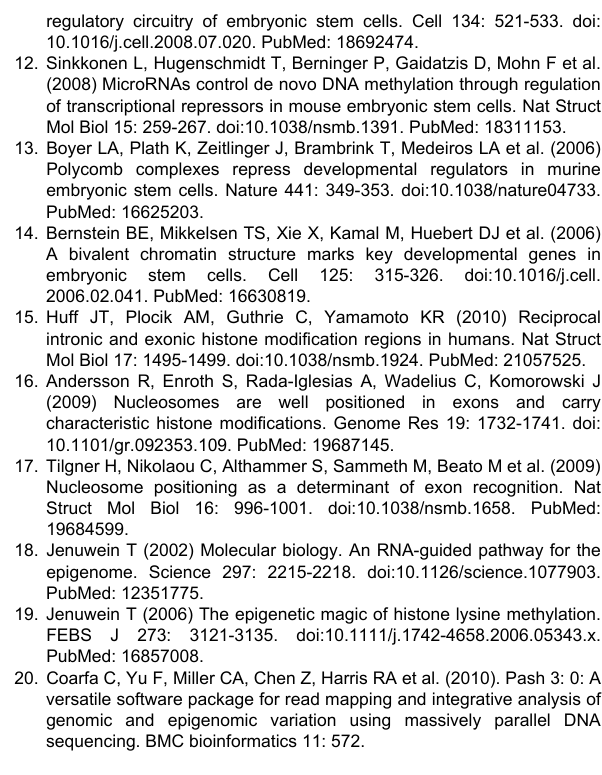
Table S2. List of primers used for ChIP-qPCR assays.